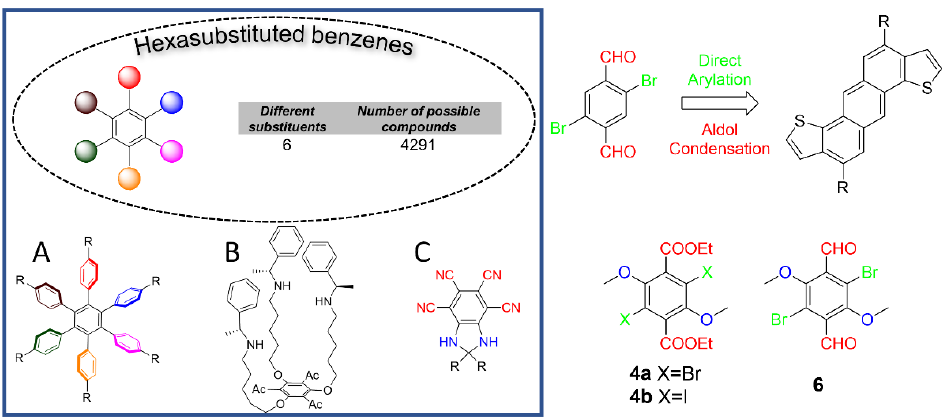
Figure 1. Schematic representation of hexa-substituted benzenes state-of-art. ( A ) hexaarylbenzenes; ( B ) C 3 -Symmetrical hexasubstituted benzenes; ( C ) Nonlinear optical materials built on hexasubsti- tuted benzene moieties.